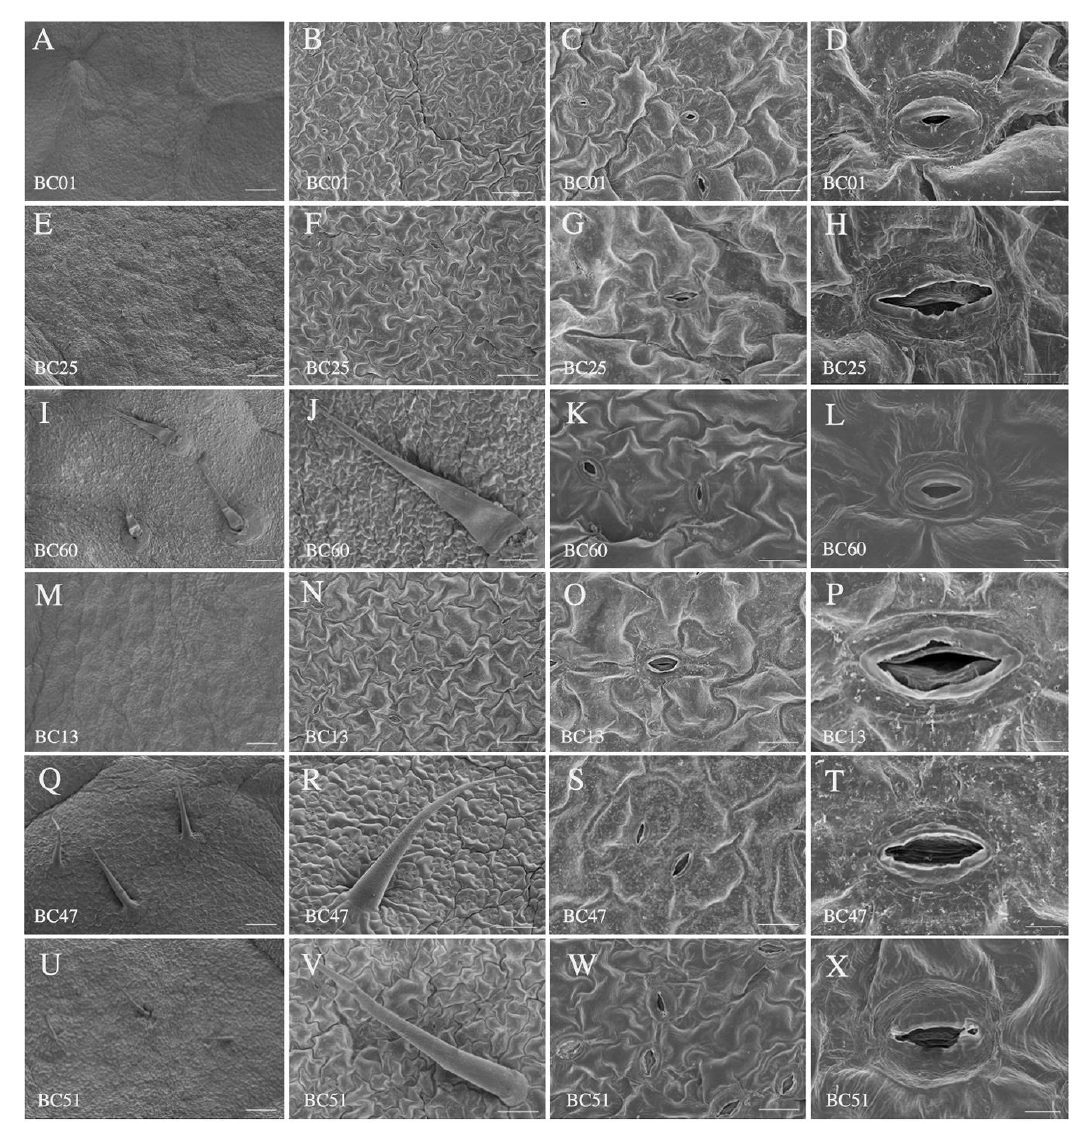
Figure 3. Characteristics of lower leaf epidermis of the susceptible and the resistant accessions. ( A – L ) Leaf lower epidermis characteristics of the susceptible accessions BC01, BC13, and BC60. ( M – X ) Leaf lower epidermis characteristics of resistant accessions BC13, BC47, and BC51. Scale bars: 250 µ m in ( A , E , I , M , Q , U ), 100 µ m in ( B , F , J , N , R , V ), 20 µ m in ( C , G , K , O , S , W ), and 5 µ m in ( D , H , L , P , T , X Table 2. Characteristics and parameters of the lower leaf epidermis and leaf structure of susceptible and resistant accessions.